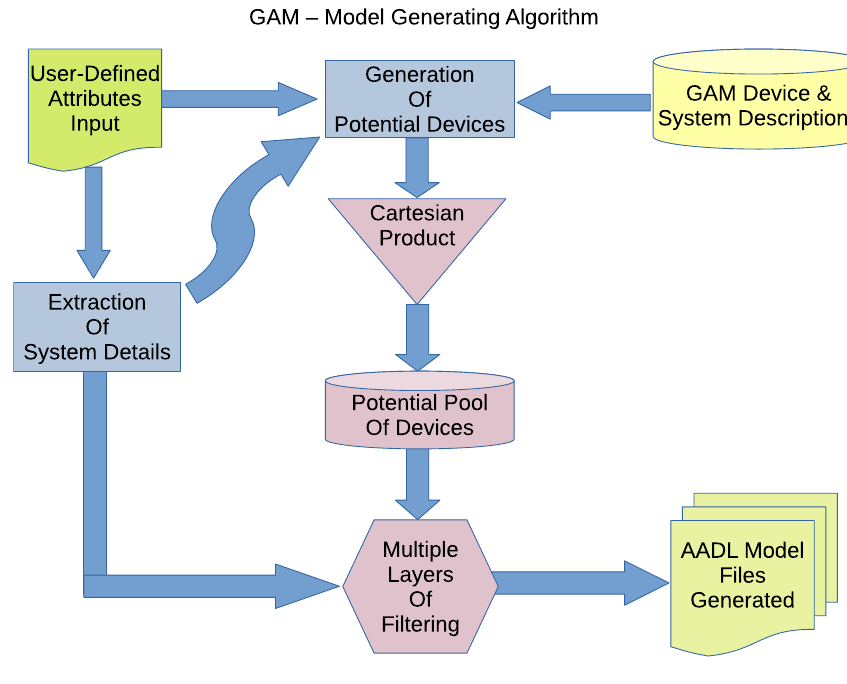
Fig. 5 Illustration of flow graph for the GAM model generating